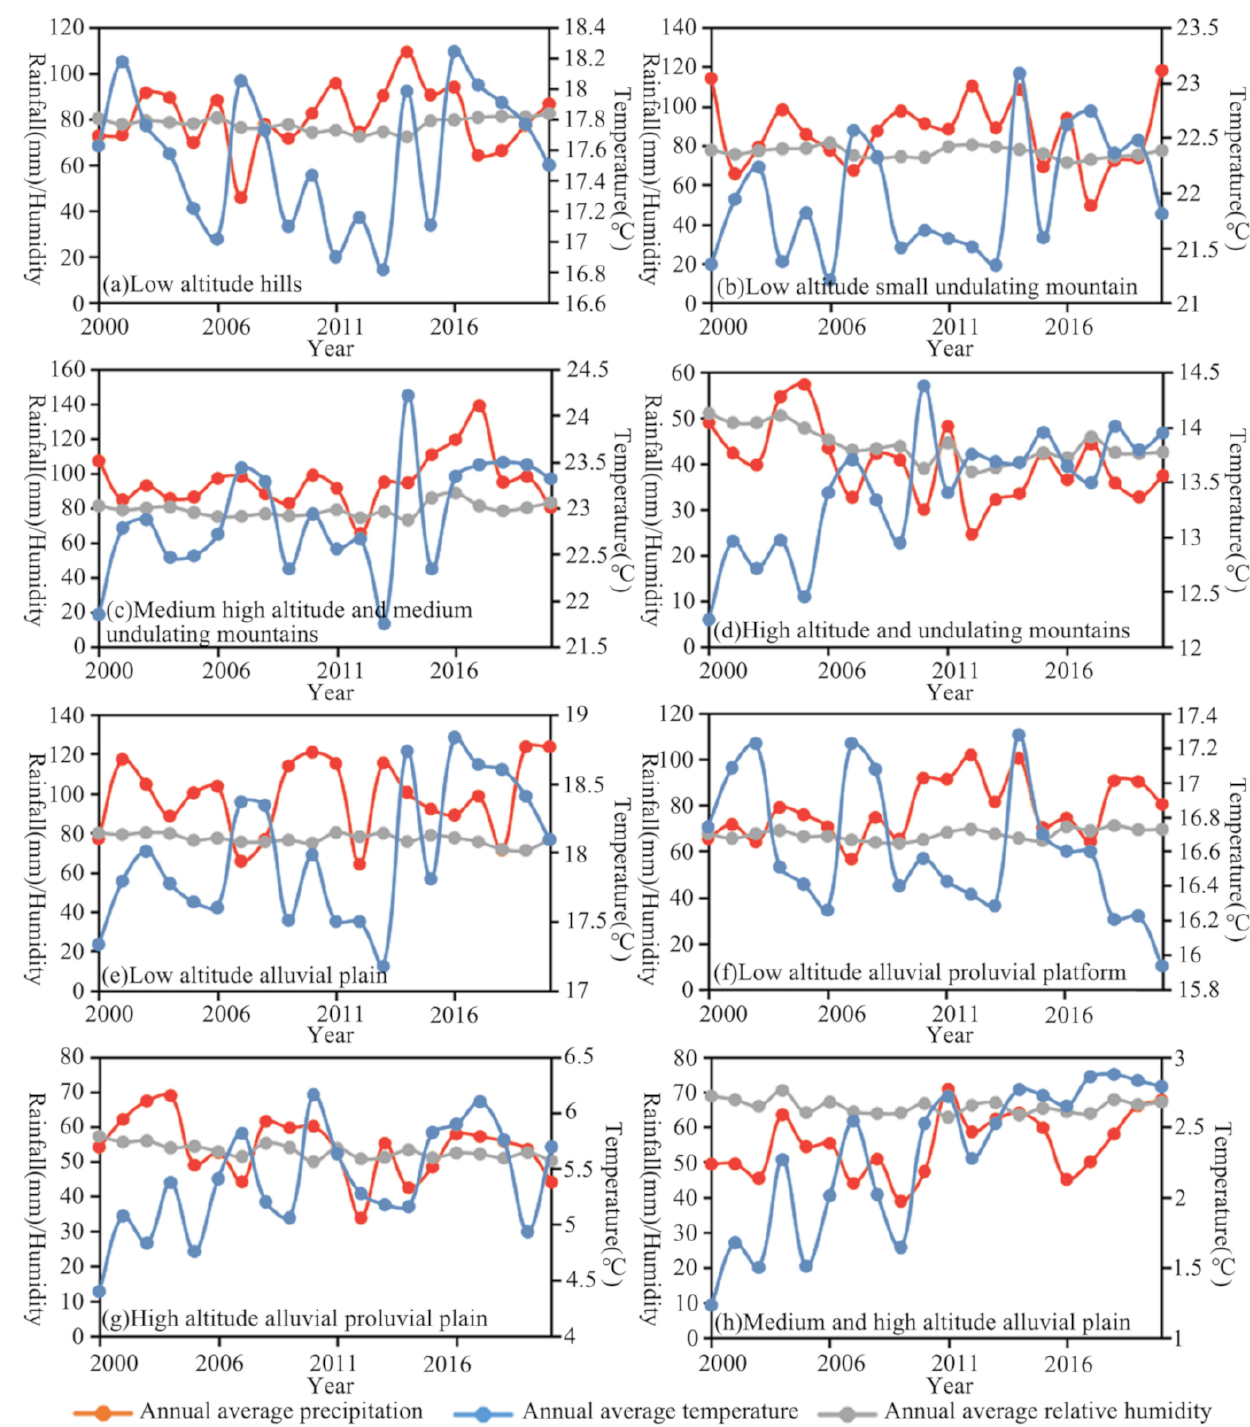
Figure 9. Changes in annual average temperature, precipitation and relative humidity in typical geomorphic